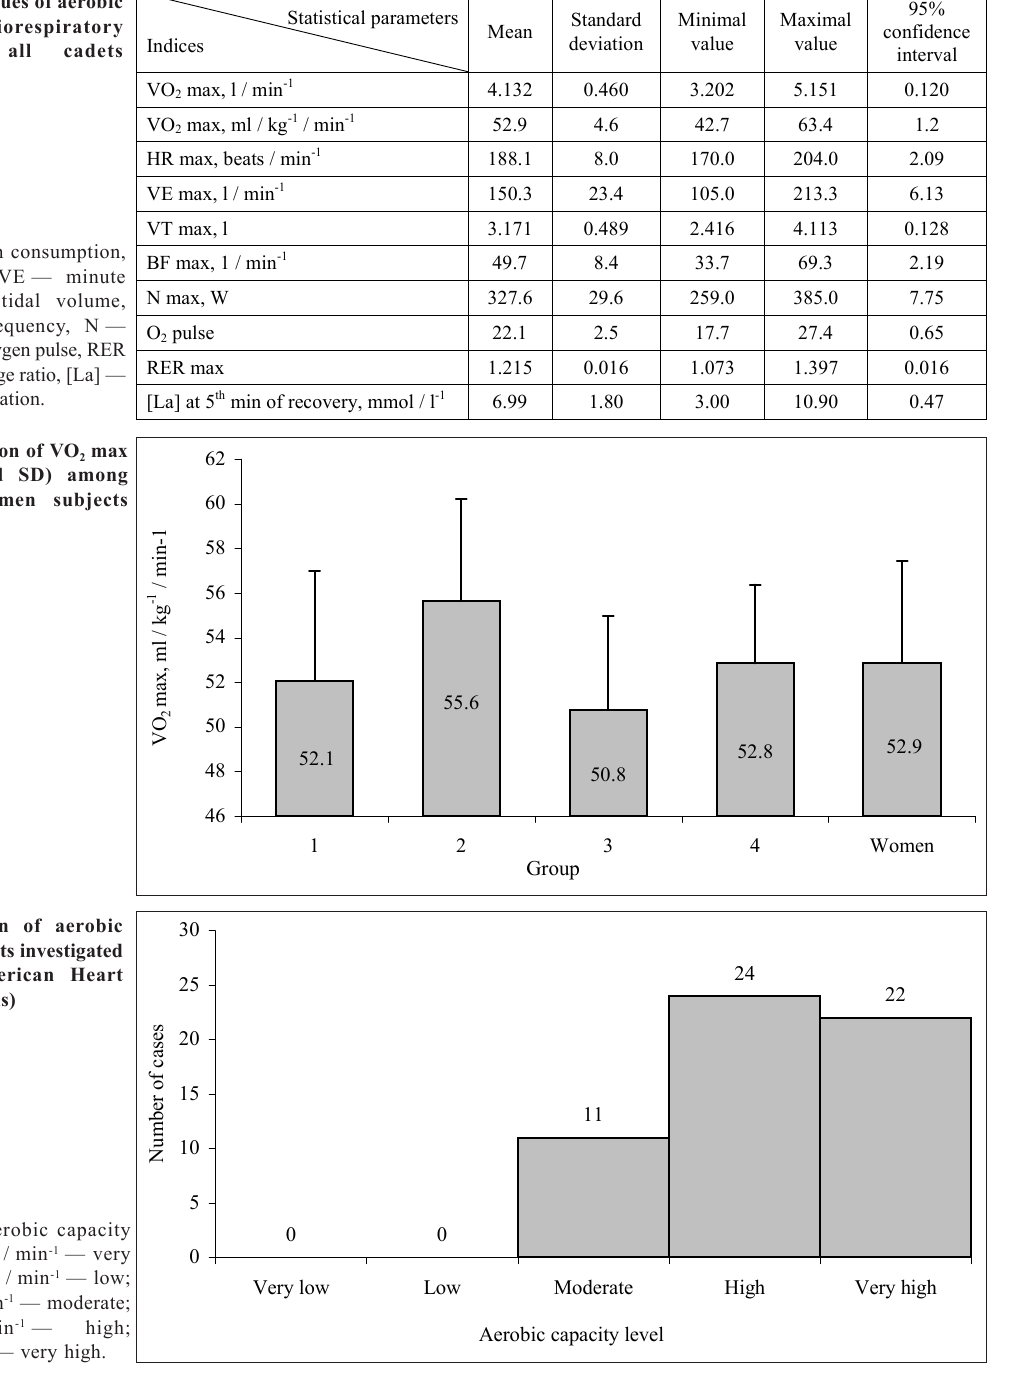
Table 2. Maximal values of aerobic capacity and cardiorespiratory parameters